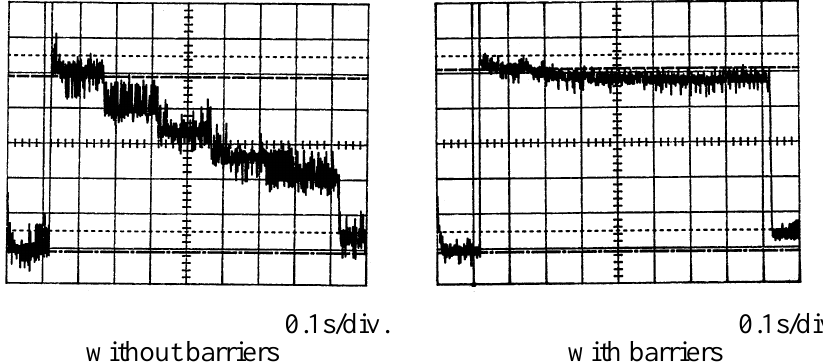
barriers0.1s/div. 0.1s/div. without barriers with FIG. 7. Slow intensity monitor signals when the injection kicker was fired five times. The horizontal axis is time with 0.1 s (cid:1) division. The vertical axis is 50 mV (cid:1) division. One bunch was injected and the intensity was 1.9 3 10 12 protons. Left: without barriers; right: phase gap of 97 ± was made by barriers to avoid beam loss.